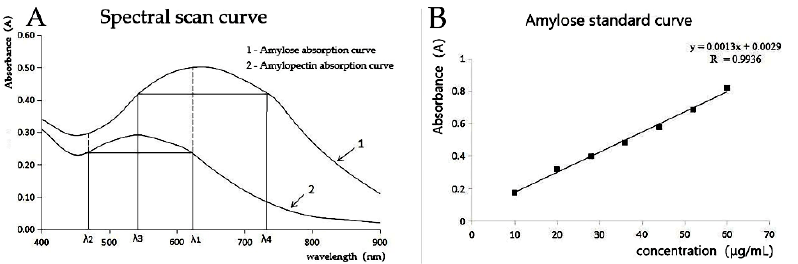
Figure 6. Drawing standard curve of AC. ( A ) The preparation analysis of amylose and amylopectin; ( B ) standard curve of